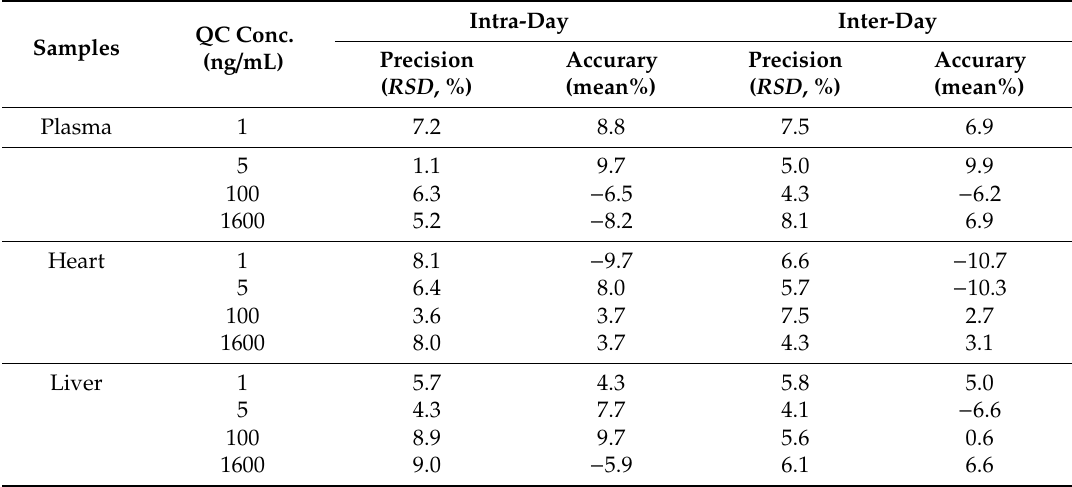
Table 2. Intra- and inter-day accuracy and precision of alnustone in the plasma and tissue homogenates of rats ( n =